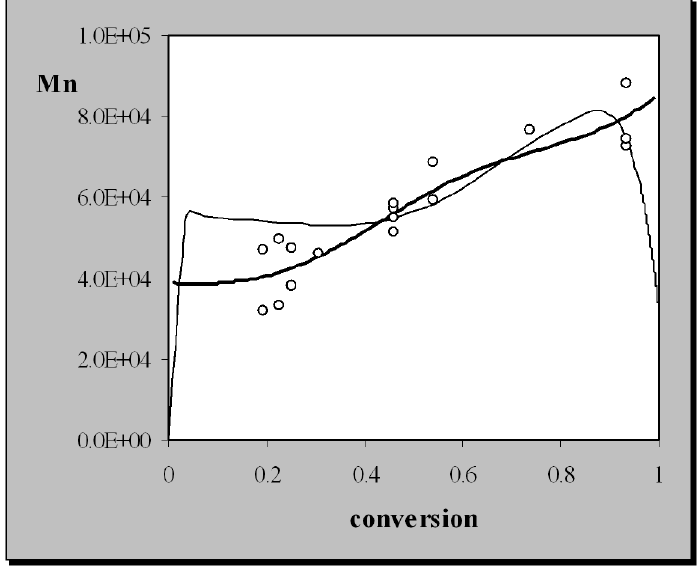
Fig. 10 Number average molecular weight obtained with MLP (3:8:1) (thick line), by simulation on the kinetic model (thin line) and experimentally (o) [15], [16] at 90 o C and 25.8 mol/m 3